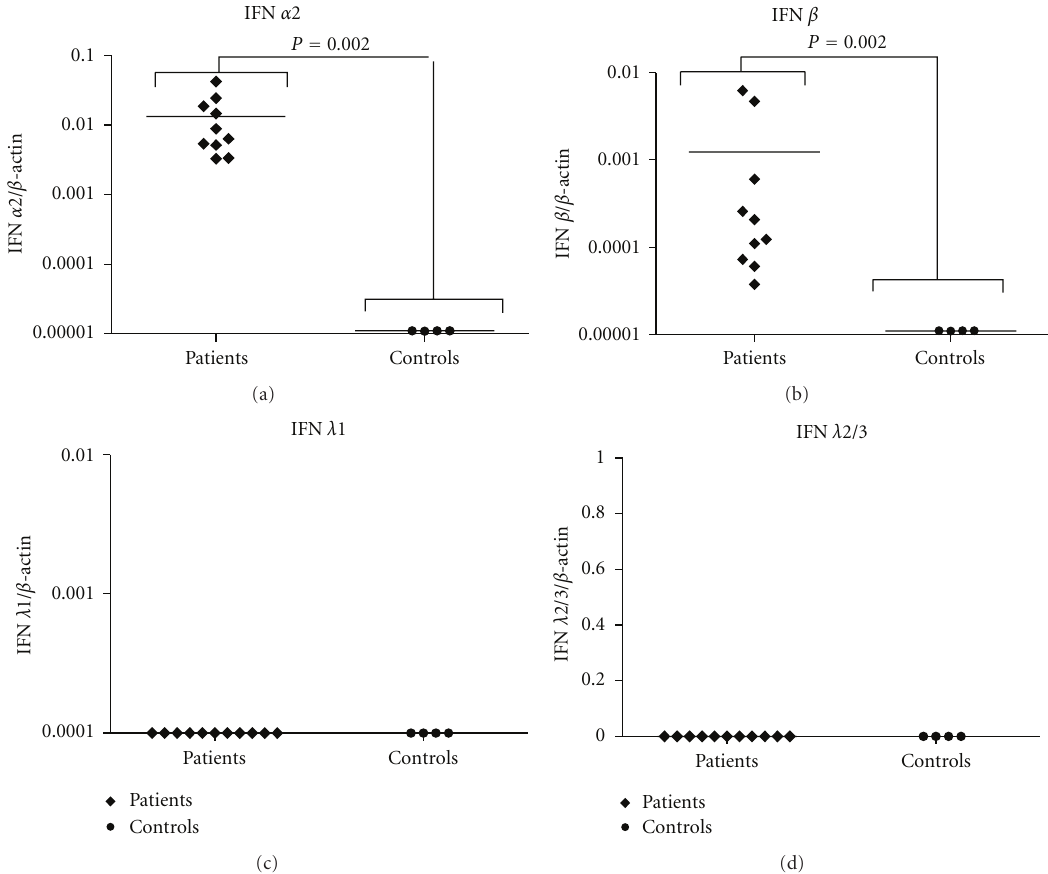
Figure 1: Type I and type III IFN mRNA basal levels in PBMCs from healthy donors and SSc patients. PBMCs from healthy donors and SSc patients were purified, and total RNA extraction was performed. The RNA obtained was used as template in reverse transcription reactions, and the resulting cDNA was used in real-time PCRs to measure IFN alpha (a), IFN beta (b), IFN lambda1 (c), and IFN lambda 2/3 (d).